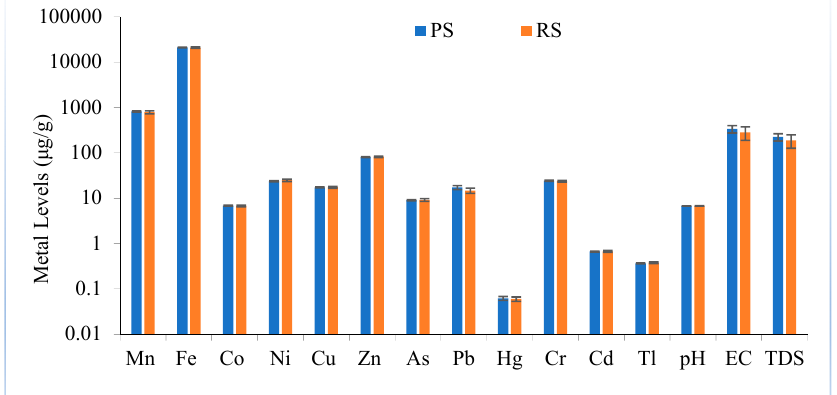
Figure 1. Comparison of average metal levels ( μ g/g, ±SE) in acid extracts of park soils (PSs) and residential soils (RSs).